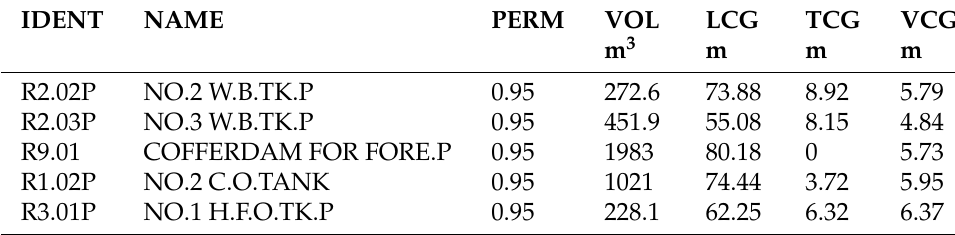
Table 7. Damaged compartments of DAM08.